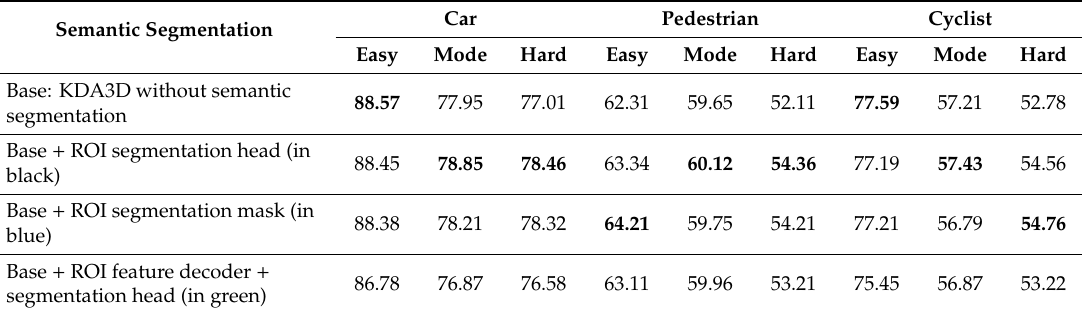
Table 7. 3D object detection performances of detectors adopting di ff erent semantic segmentation branch designs. Average Precision (AP 3D in %) of 3D boxes on KITTI’s val set. We use a 3D IoU threshold of 0.7 for the car class and 0.5 for the pedestrian and cyclist classes. The baseline detector is our KDA3D without any semantic segmentation branch. The design in the second row is KDA3D’s final